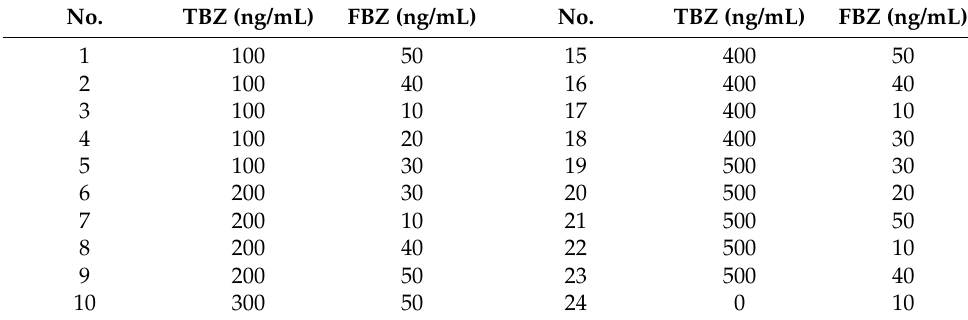
Table 5. Concentration of 27 calibration sets.